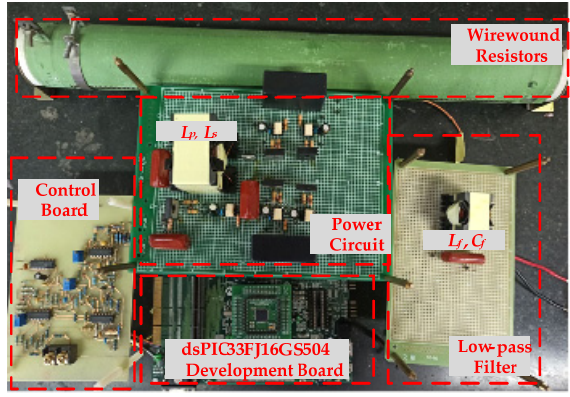
Figure 18. Photograph of the experimental prototype.